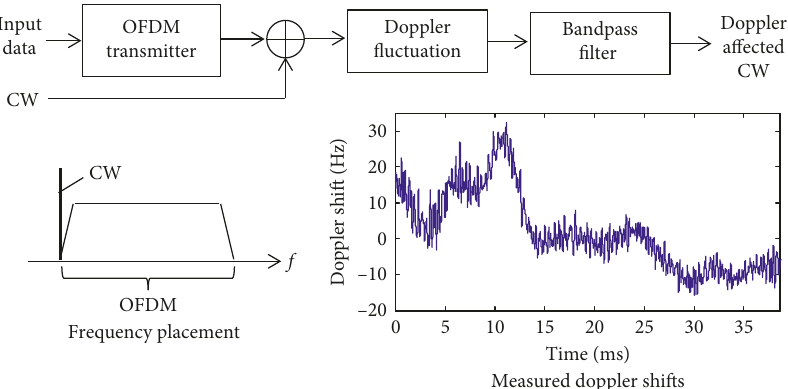
Figure 8: Block diagram of CW-aided Doppler estimation.